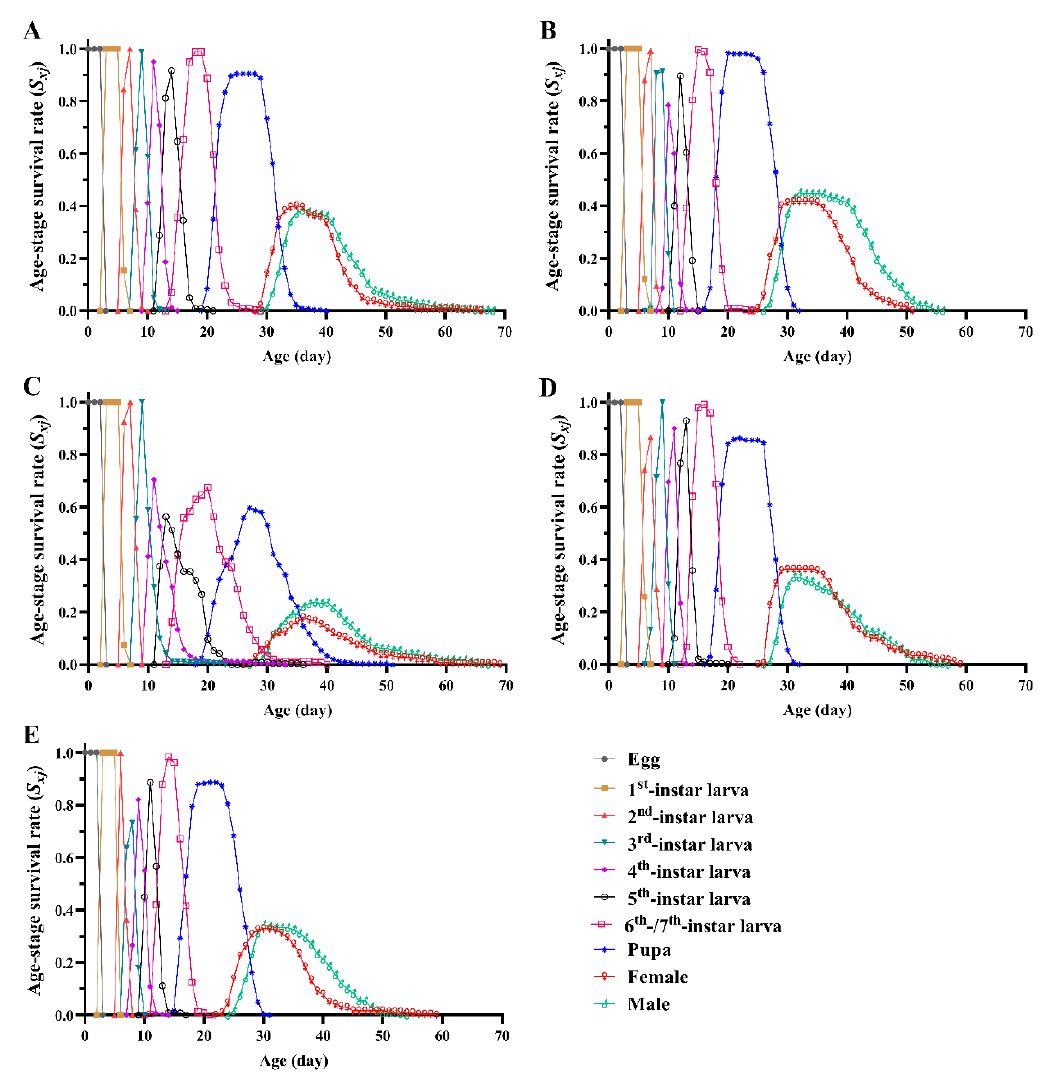
Figure 2. Age-stage survival rate ( s xj ) of Spodoptera frugiperda individuals fed different diets. ( A ): D 1 ; ( B ): D 2 ; ( C ): D 3 ; ( D ): D 4 ; ( E ): maize leaves.